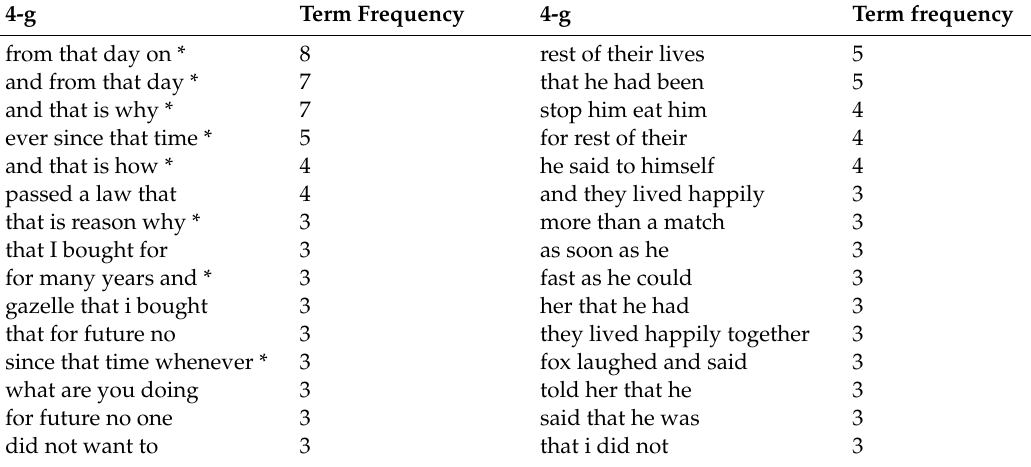
Table 8. Term frequencies for 4-g ending of 252 African (left) and 490 European folk tales (right). 4-g Term Frequency 4-g Term frequency from that day on * 8 rest of their